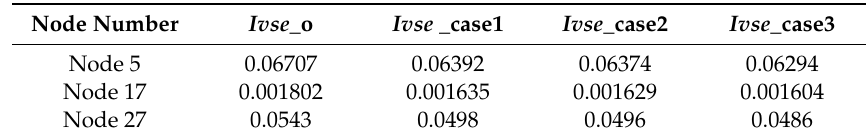
Table 4. Index value of Ivse with electric